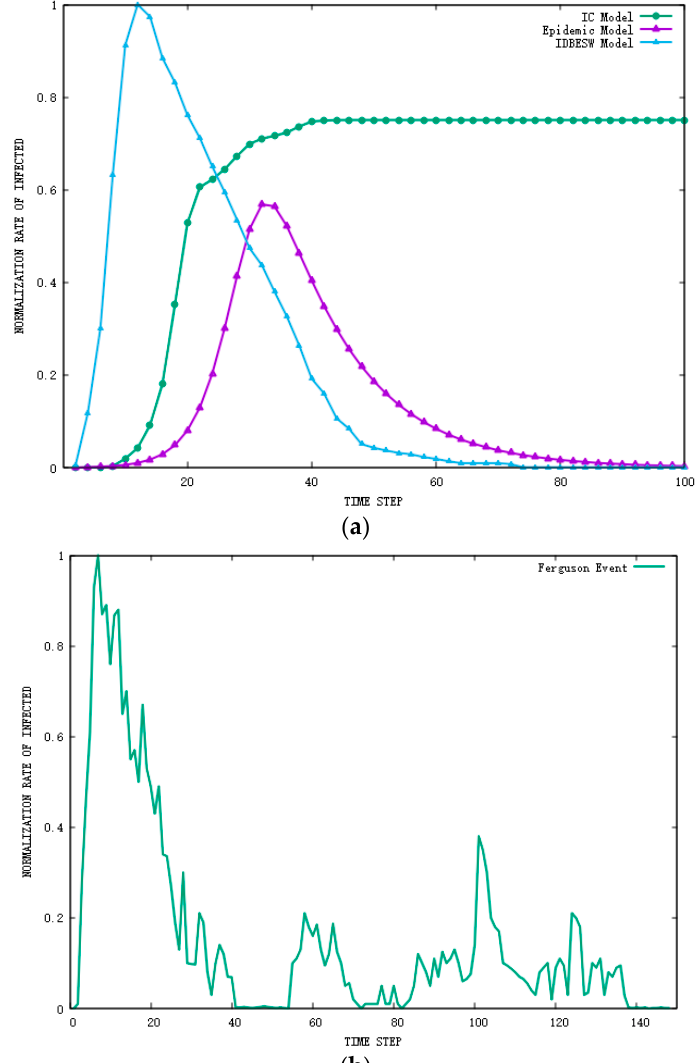
Figure 6. Comparison of the IDBESW model with traditional models and real diffusion propagation. ( a ) Comparison between our model with the traditional model using the Twitter dataset. ( b ) Actual information propagation trends of the Ferguson event in the Twitter dataset.